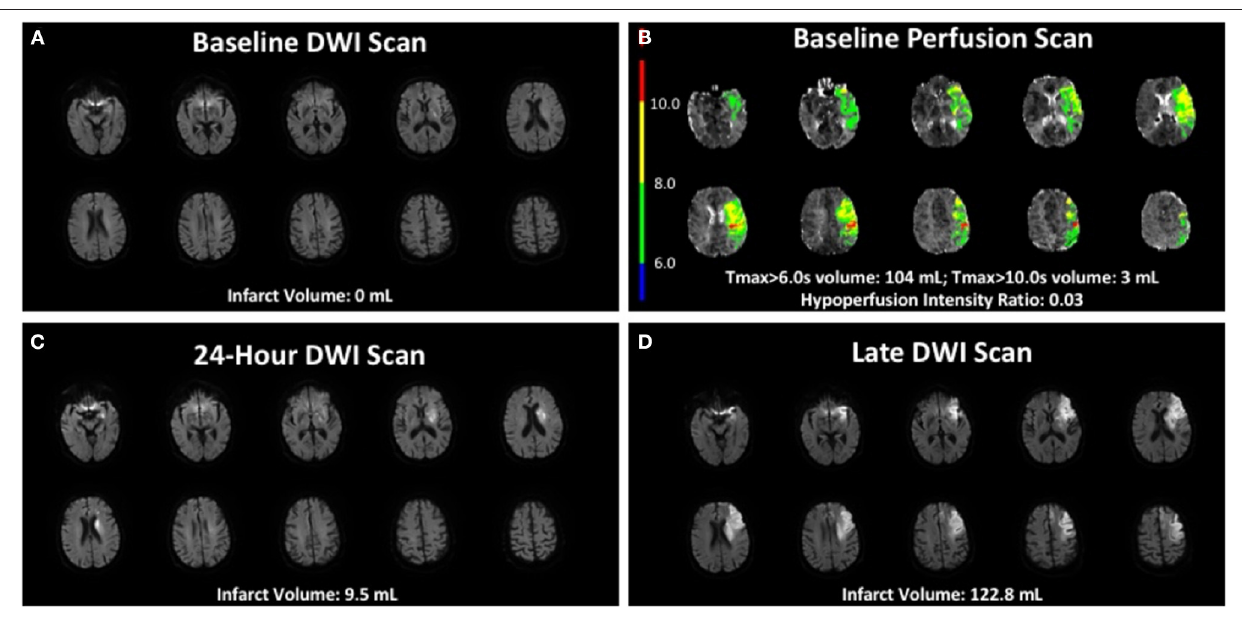
FIGURE 2 | Case example of baseline DWI and perfusion scan, a 24-h DWI scan, and a late DWI scan. Seventy-eight-year-old patient with 12h of symptoms prior to baseline MRI, with good baseline collaterals but who did not reperfuse with imaging demonstrating minimal early infarct growth and substantial late infarct growth.